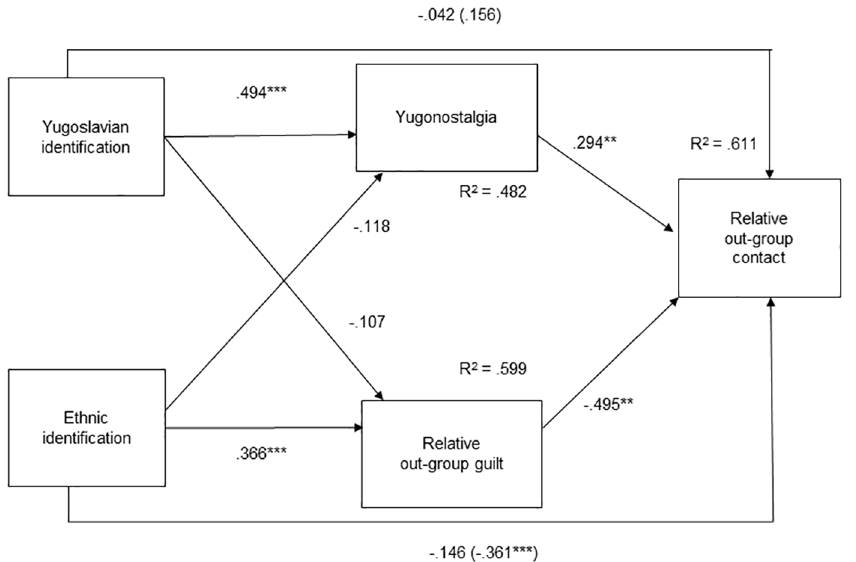
Figure 1. Results from a structural path model predicting relative out-group contacts among Croats, Serbs and Bosniaks in Australia ( N = 87). Note . Standardized coefficients presented, total effects in the brackets; the covariance of the two mediators (ß = -.008, p = .935) and the two independent predictors (ß = -.311, p = .003) was accounted for. We controlled for significant ethnic group differences in relation to the